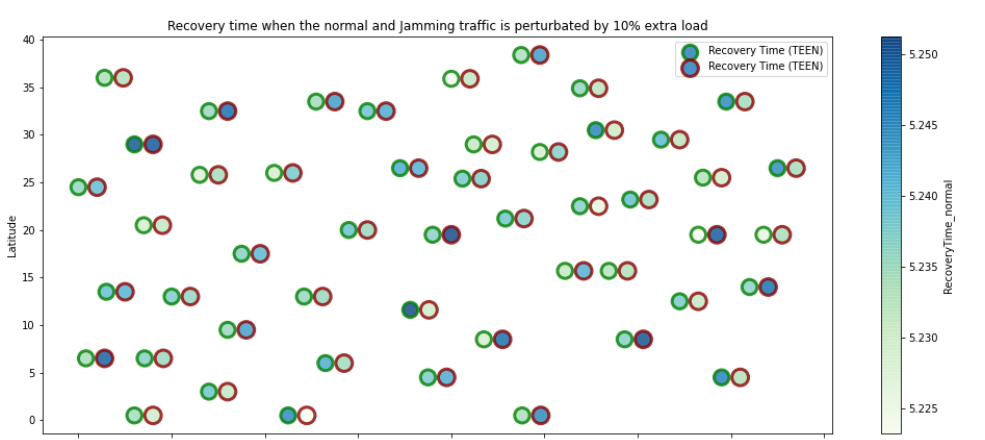
Figure 3. TEEN energy under normal conditions and jamming.